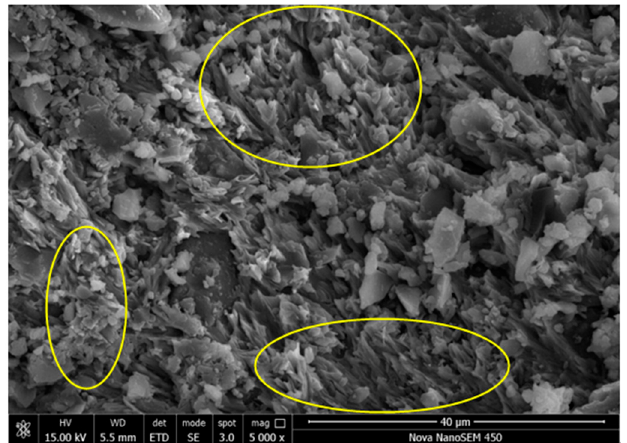
Figure 12. 5000× SEM image of coal powder treated by the developed SDS ‐ SPI cementing dust Figure 12. 5000 × SEM image of coal powder treated by the developed SDS-SPI cementing dust suppressant solution with optimal spray concentration. suppressant solution with optimal spray